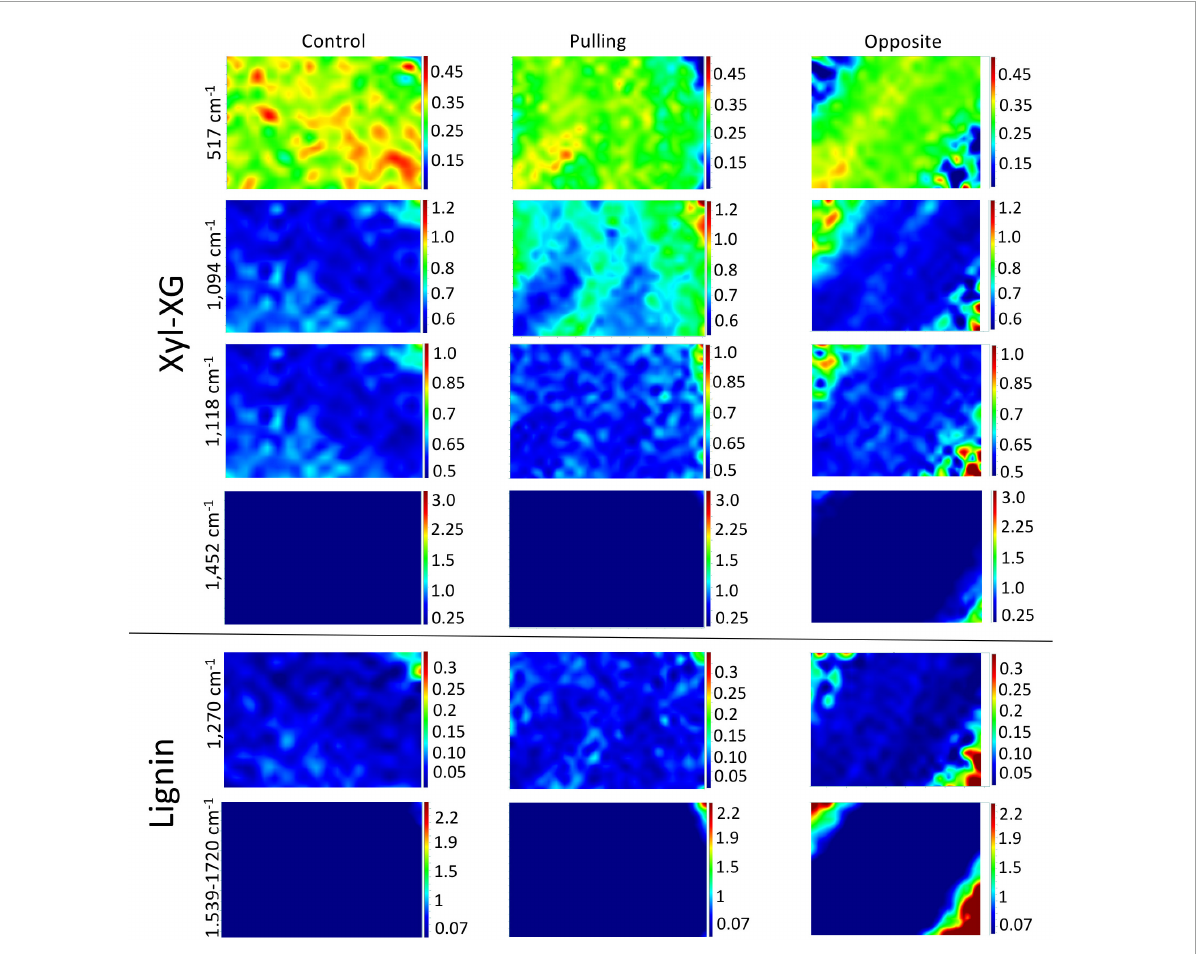
FIGURE7 Raman chemical cartography of ratio (major band/reference band 379 cm − 1 ): major contributions of xyloglucan-XG (517; 1,094; 1,452 cm − 1 ), xylan-X (1,118 cm − 1 ), lignin (1,270; 1,539–1,720 cm − 1 ). Color scale bar indicates pixel intensity for the imaged peak (red = high, blue = low). Within one peak, the color scale intensities were the same for each